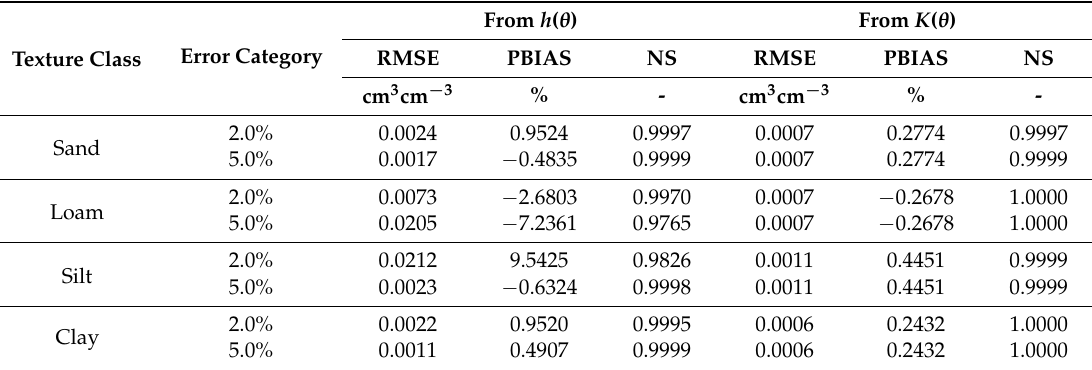
Table 8. Soil water content errors from estimated SWRCs and SWCCs considering random errors on cumulative infiltration for the four typical